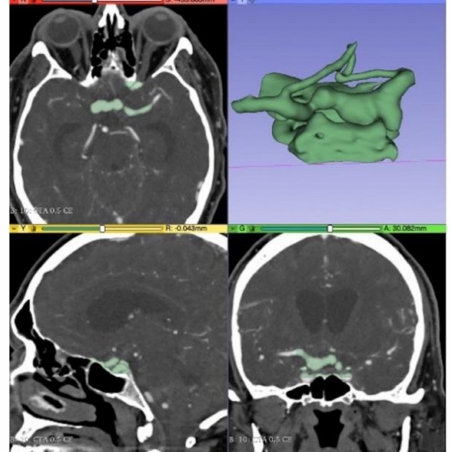
Figure 1. Segmentation using 3D Slicer